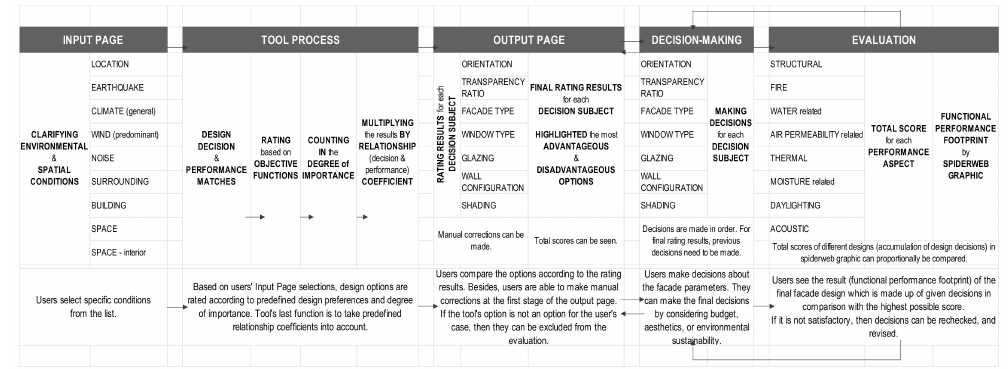
Figure 1. Working principle of the tool.